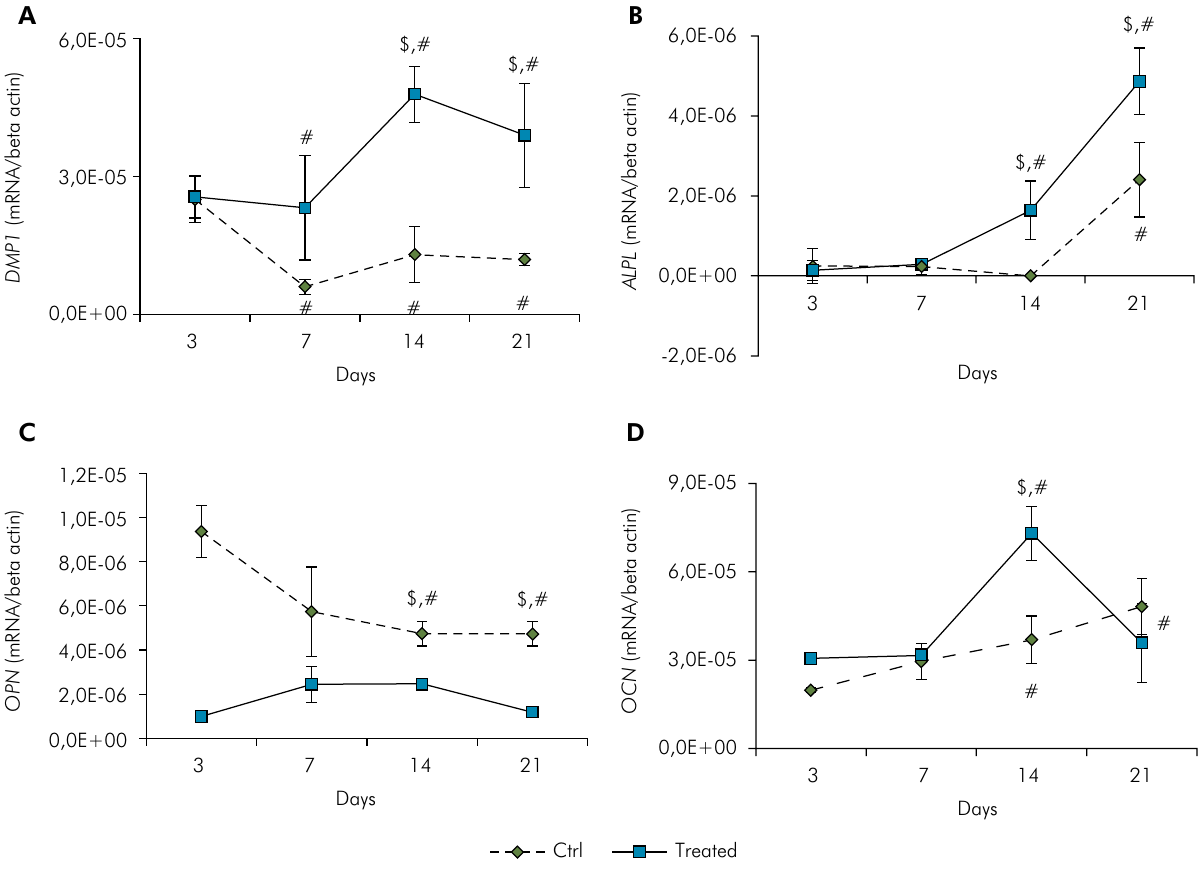
Figure 3. Effect of osteogenic induction on the expression of DMP1 , ALPL , OPN , and OCN at 3, 7, 14, and 21 days after treatment (Pi-treated). # Intragroup difference by one-way ANOVA followed by the Bonferroni test versus day 3 with alpha = 0.05. $ Intergroup difference by Student t-test with alpha =